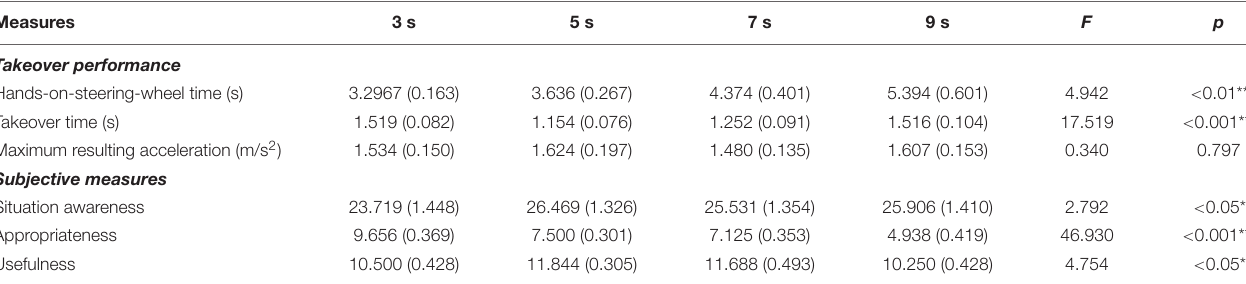
TABLE 2 | Mean and standard errors of the takeover performance and subjective ratings with different time intervals.